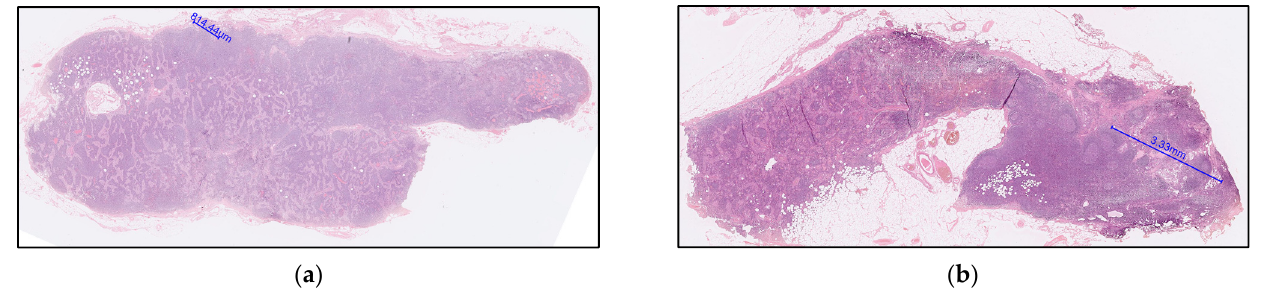
Figure 4. Explanation of the two false-negative cases based on the RadSignature. ( a ) A 40-year-old patient with grade 2 endometrioid adenocarcinoma with squamous differentiation, low segment and cervical stromal involvement, pathological staging T2N1mi; tumor size of 6.5 cm, and serum CA125 level of 37.3 U/mL. The lymph node (LN) was regarded false- negative based on the RadSignature criteria: mean ADC value of the tumor (ADCt mean : 0.928 × 10 − 3 mm 2 /s), skewness of the relative ADC value (rADC skewness : 0.051), short-axis diameter of LN (1.506 mm) and skewness ADC value of the LN (0.413 × 10 − 2 ). Microscopic nodal metastasis with a tumor nest size of 0.8 mm was identified based upon the hematoxylin and eosin (H&E) stain. ( b ) A 6-year-old patient with grade 2 endometrioid adenocarcinoma, no low segment and cervical stromal involvement, pathological staging T1bN1a; no low segment involvement, tumor size 1 cm, CA125 = 24.3 U/mL. The LN was regarded false-negative based on the RadSignature criteria: mean ADC value of the tumor (ADCt mean : 0.779 × 10 − 3 mm 2 /s), skewness of the relative ADC value (rADC skewness : 2.3263), short-axis diameter of LN (3.364 mm) and skewness ADC value of the LN (2.178 × 10 − 2 ). Nodal metastasis with a tumor nest size of 3.3 mm was identified based upon the H&E stain. Table 4. Pairwise comparisons of ROC curves in detecting pelvic lymph node metastasis. Table 5. Subgroup analysis of diagnostic accuracy of MR imaging for detecting pelvic lymph node metastasis.